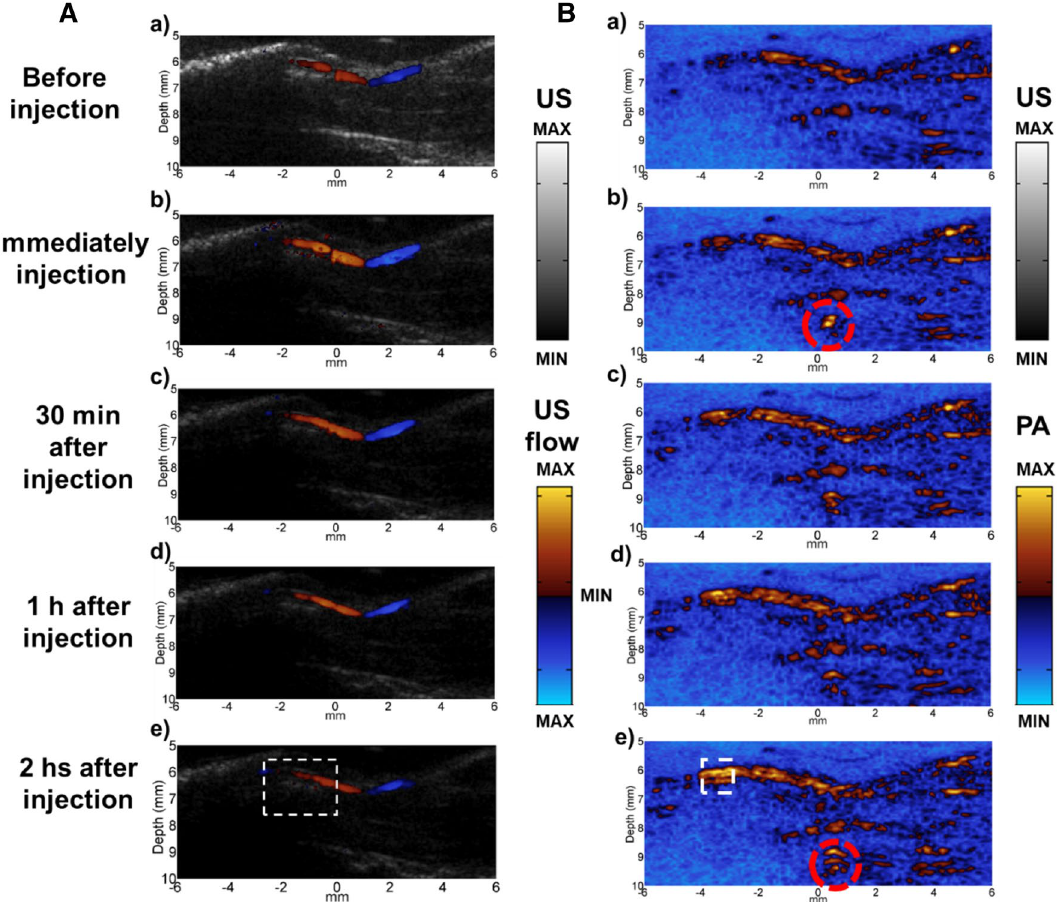
Figure 5. The images of US (blood) flow ( A) and PA ( B ) at different time points: Both subfigure a) in ( A ) and ( B ) were the US flow and PA image before injection. (b–e) were the US flow and PA images immediately after injection, 30 min after injection, 1 h after injection and 2 h after injection respectively. White dashed squares are the area evaluated quantitatively.